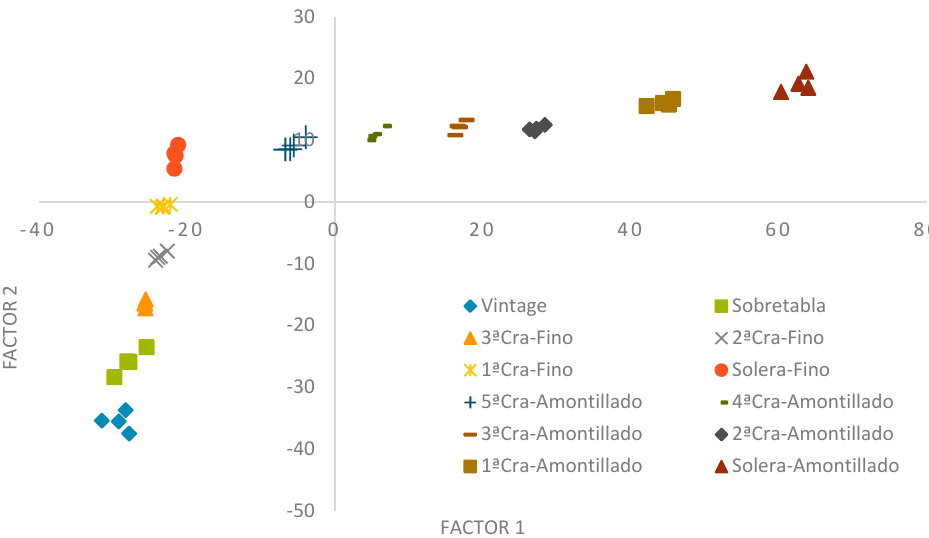
Figure 3. Projection of the wines on the plane of Factors 1 and 2 obtained after Principal Components analysis. Table 9. Coefficients of Factors 1 and 2 after varimax rotation of the variables that have shown the highest correlation (r > 0.8).